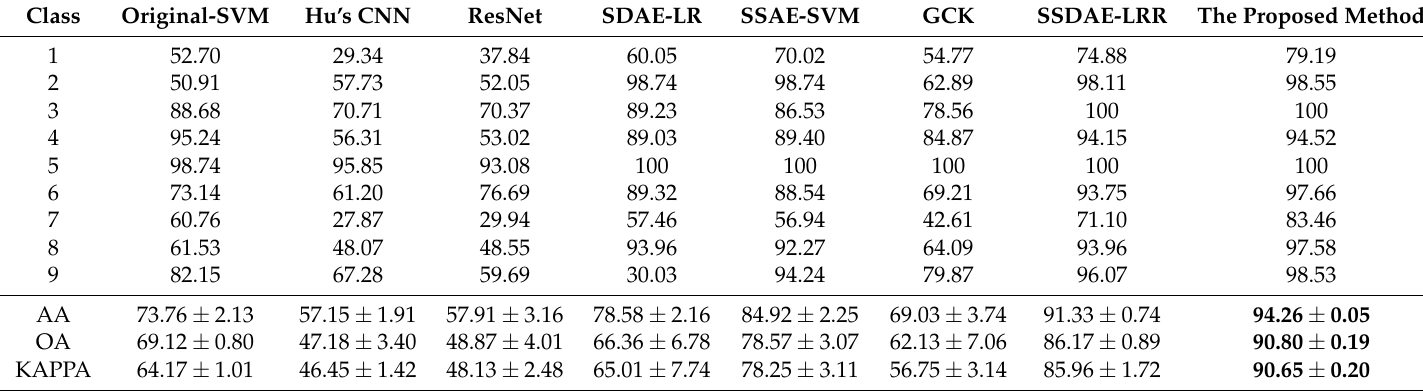
Table 6. Classification accuracy (%) of different methods on Indian Pines dataset (a total of 100 labeled samples were used for training).